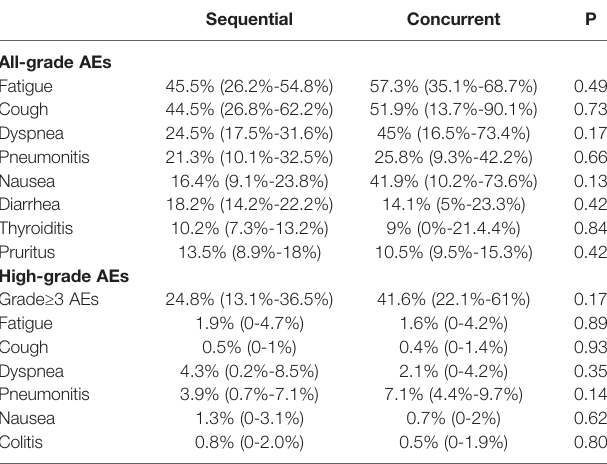
TABLE 5 | Difference in incidence of AEs with concurrent vs sequential ICIs and thoracic radiotherapy. Sequential